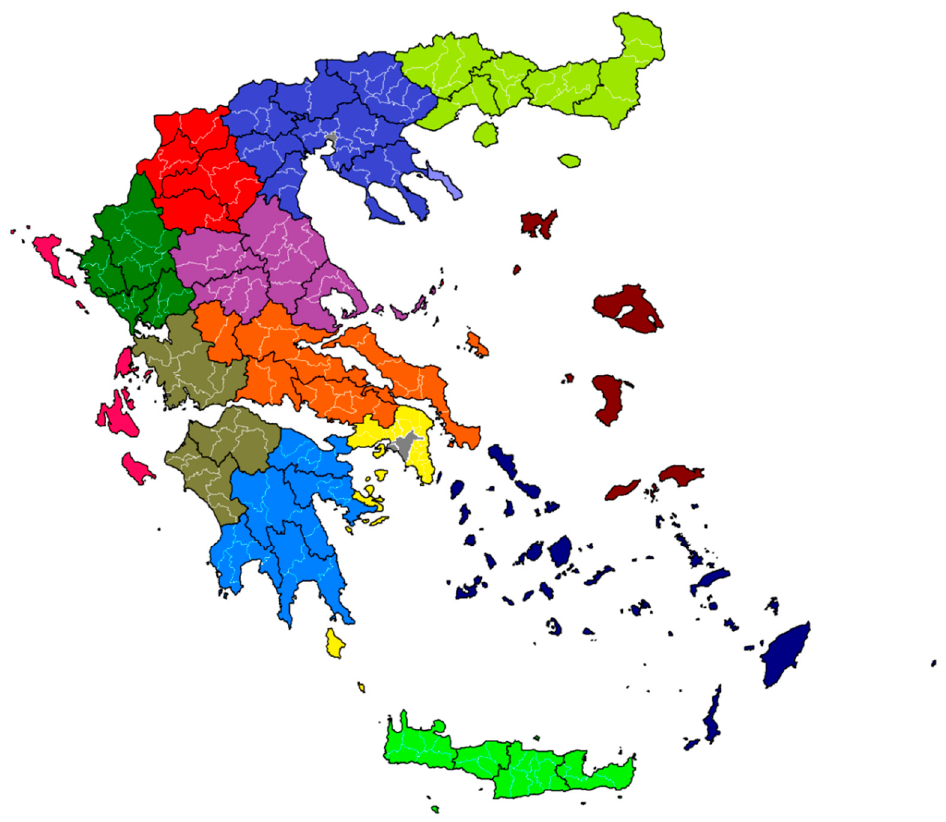
Figure 5. The administrative division of Greece. This image shows the 13 Regions, the 51 Prefectures and the 332 Municipalities of Greece (source: https://en.wikipedia.org/wiki/Administrative_divisions_of_Greece (accessed on 4 July 2022).